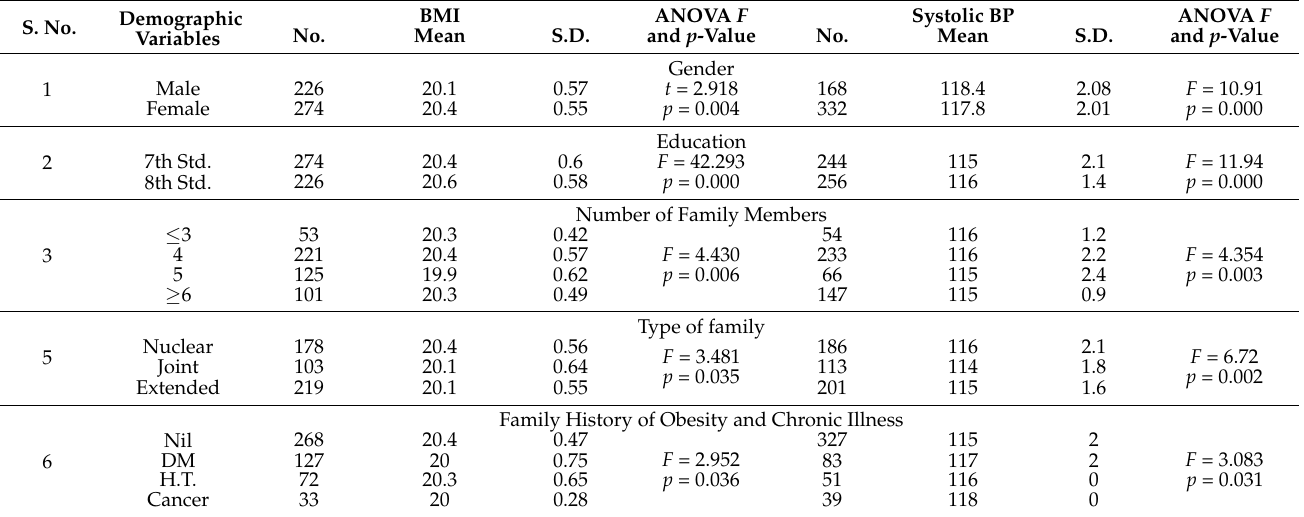
Table 4. Association between BMI and Systolic B.P. with Demographic Variables of study group adolescents. S.